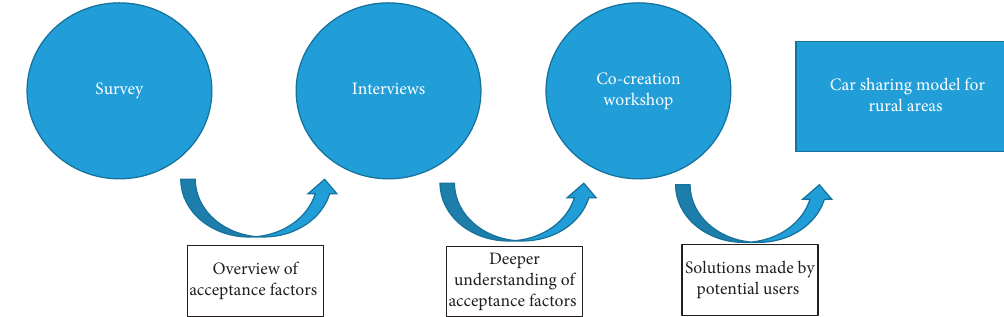
Figure 1: Diagram of the methodological approach used.